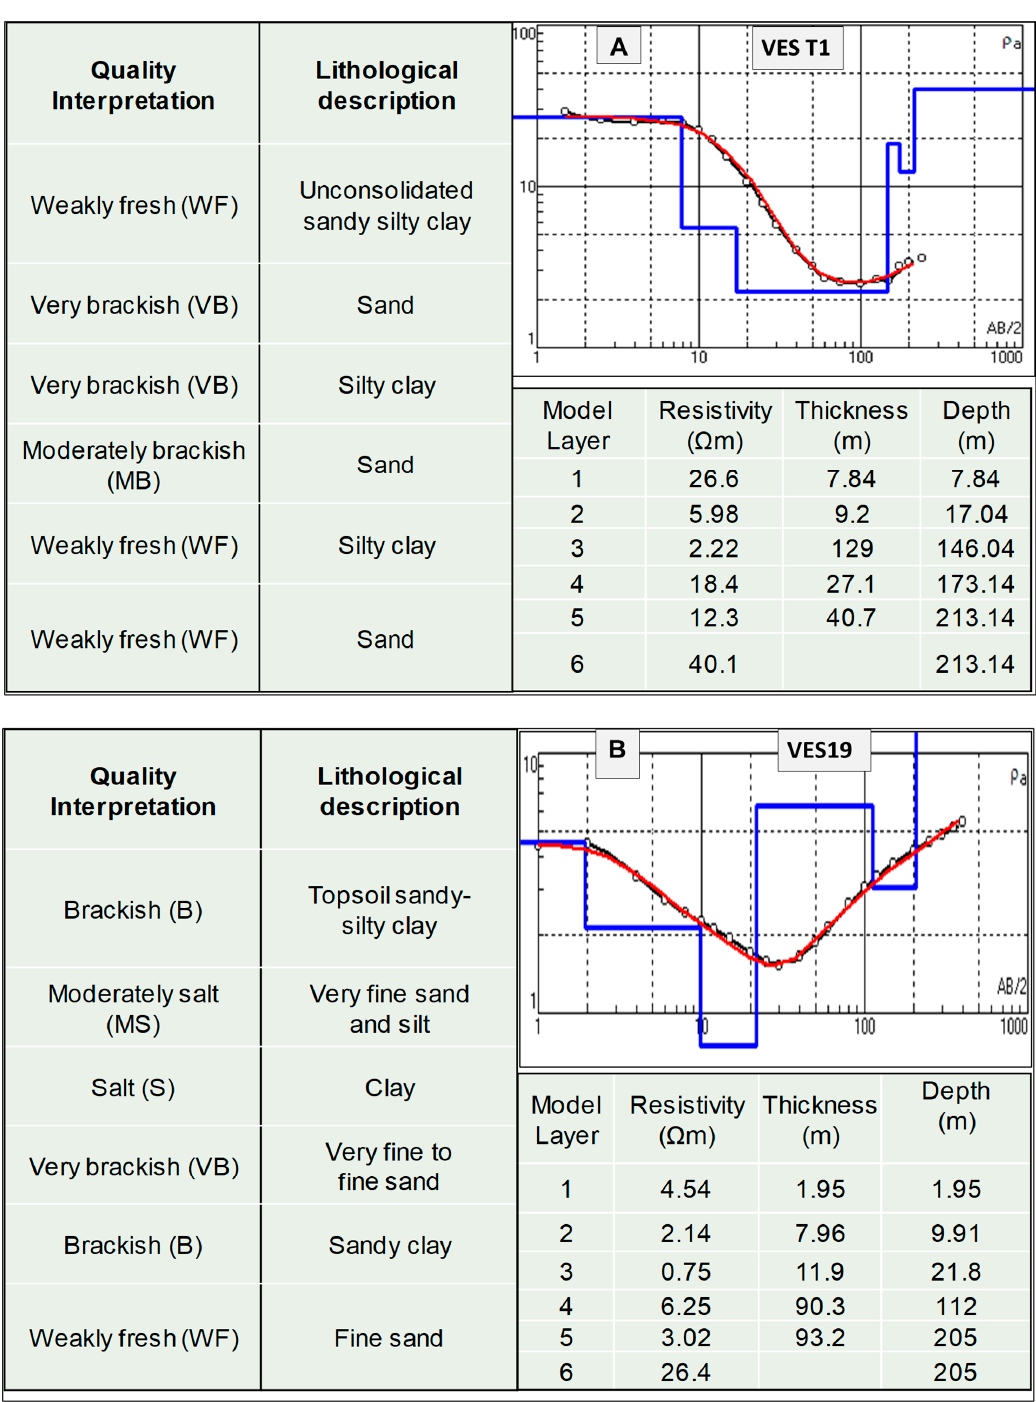
Figure 5. Example 1-D models obtained from inversion of resistivity data at VES T1 ( A ) and VES 19 ( B ) located in the northeast and south of the study area, respectively. Open circles with black line and the red line are the measured VES data and calculated VES data, respectively. The solid blue line is the estimated subsurface resistivity of the geo-electric layers.